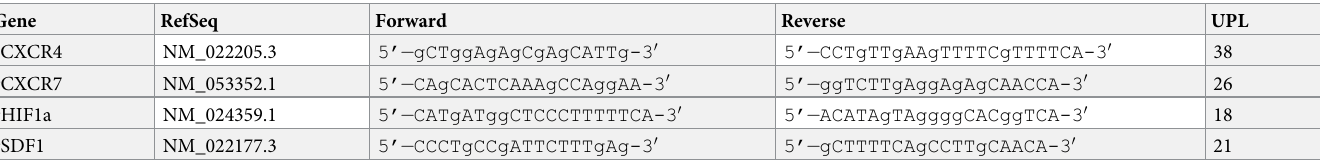
Table 2. The studied genes with their sequences and probe number. Gene